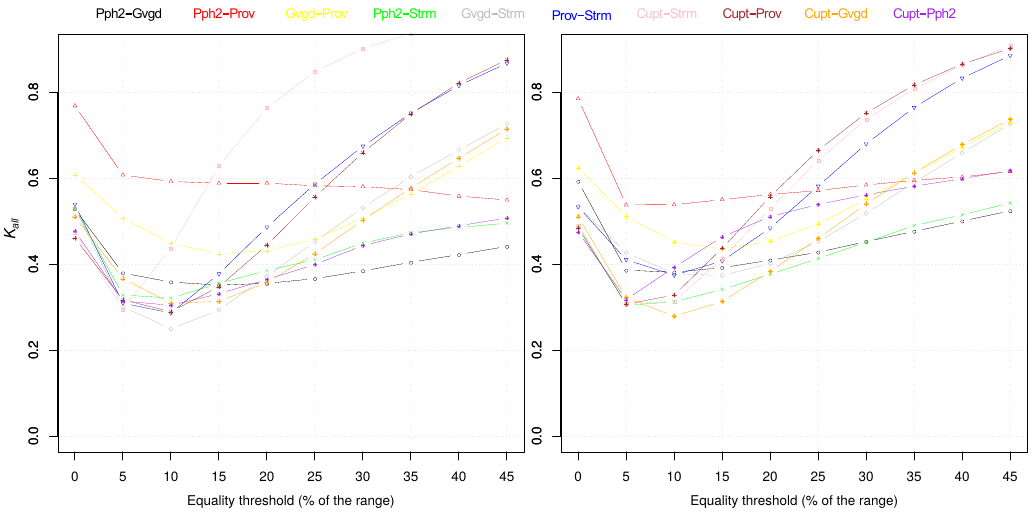
Figure 1. Threshold analysis. (left) DM-V dataset and (right) CHKV-E2